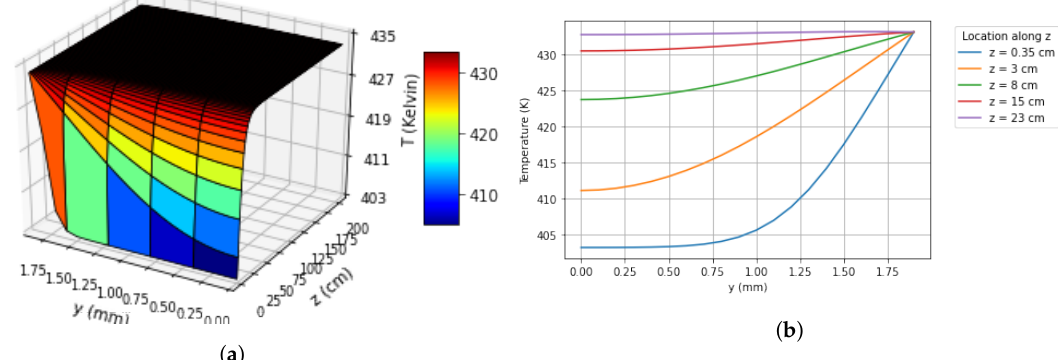
Figure 3. Finite difference solutions of temperature distribution of fluid flow in parallel-plate. ( a ) 3D view of temperature distribution in parallel-plate; ( b ) temperature profile along